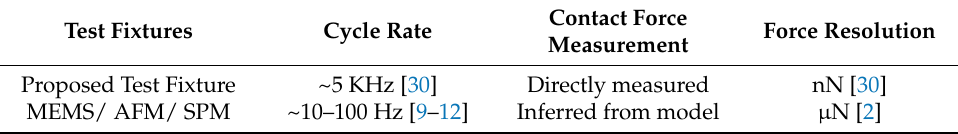
Table 1. Performance comparison between proposed and conventional test fixtures.